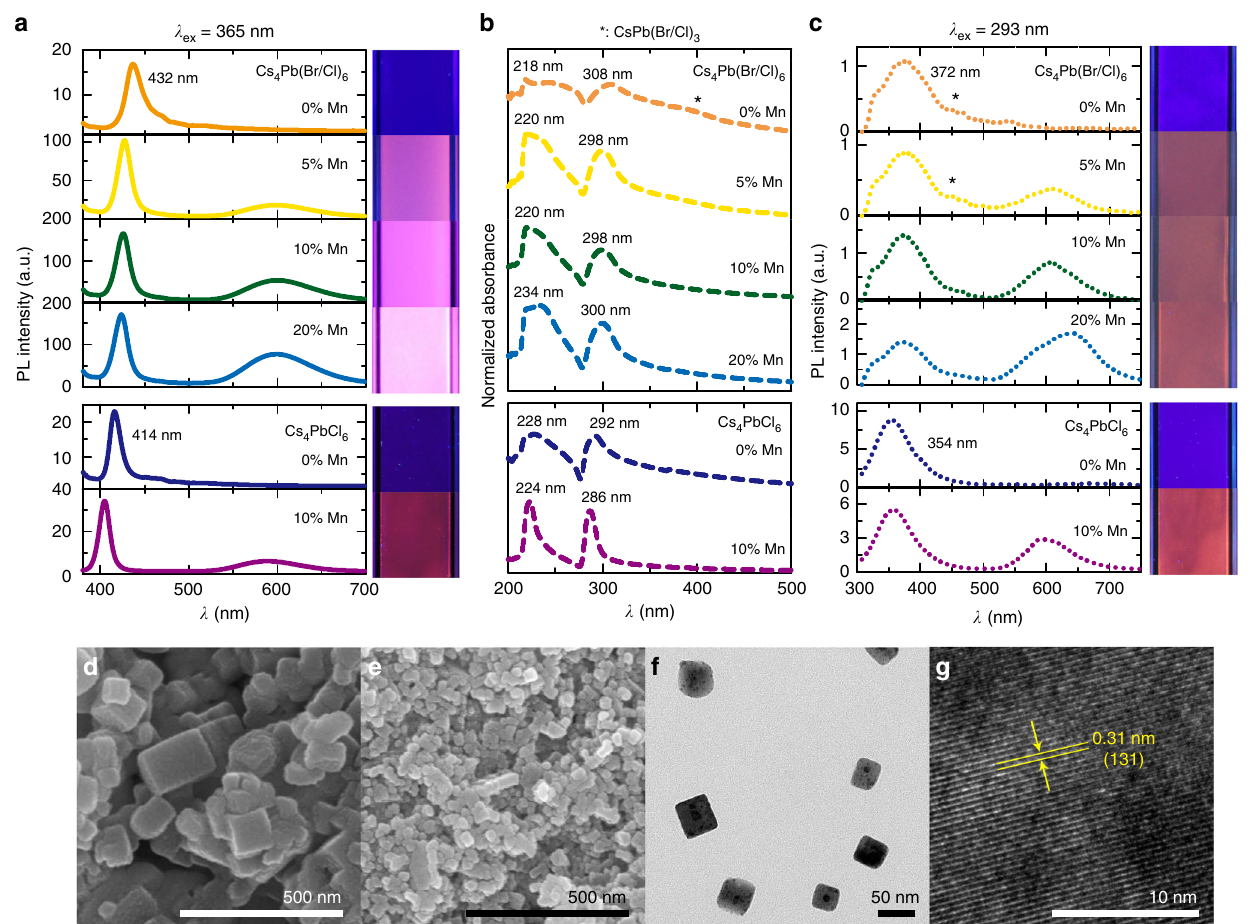
Fig. 2 Luminescent properties of Mn 2 + -doped Cs 4 PbX 6 . a PL spectra of Mn 2 + -doped Cs 4 PbX 6 colloids were measured under 365 nm excitation, where X = Br/Cl and Cl, with Mn contents denoted as 0% Mn, 5% Mn, 10% Mn, and 20% Mn and the insets shows the respective samples under 365 nm UV the insets shows the respective samples under 254 nm UV lamp. The PL spectra presented are the PL intensities corrected using optical density. The asterix mark denote the 3D CsPb(Br/Cl) 3 phases. FE-SEM images of d undoped Cs 4 Pb(Br/Cl) 6 and e Cs 4 Pb(Br/Cl) 6 :10% Mn, and f , g HR-TEM images of Cs 4 Pb(Br/Cl) 6 :10% Mn. A lattice spacing of 0.31 nm corresponding to (131) plane of rhombohedral structure of Cs 4 Pb(Br/Cl)